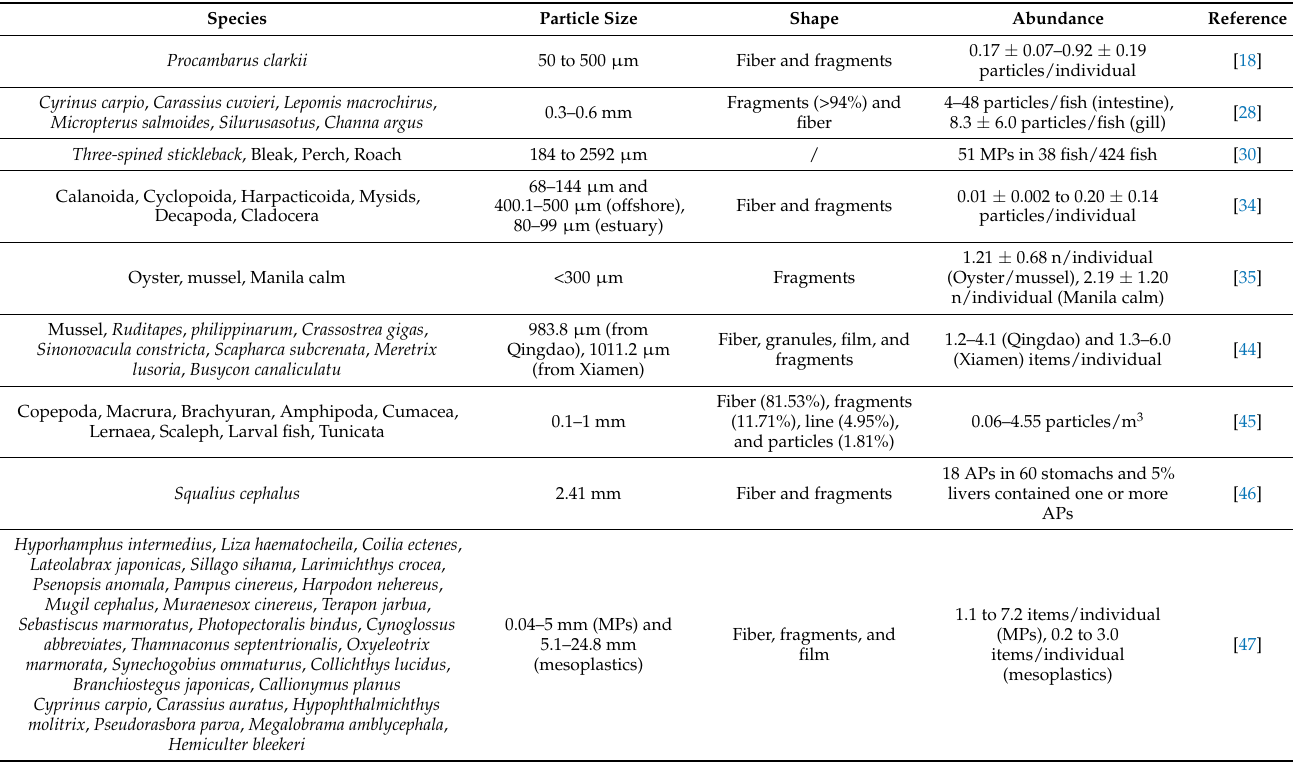
Table 2. Characteristics of MPs found in fish and fish